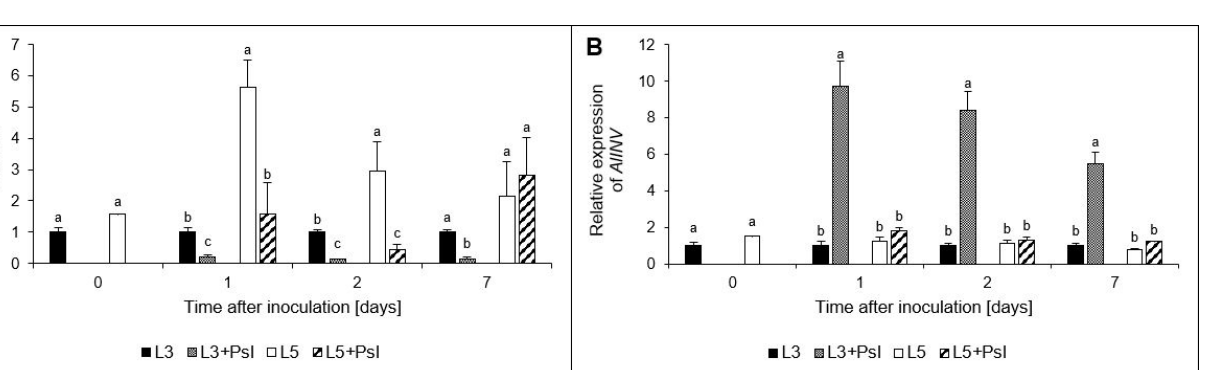
Values are means of four replicates (±SD). Different letters (a–d) indicate significant ( p ≤ 0.05) differences between experimental variants within a given time point. “-“ not detected; dai—days after inoculation.